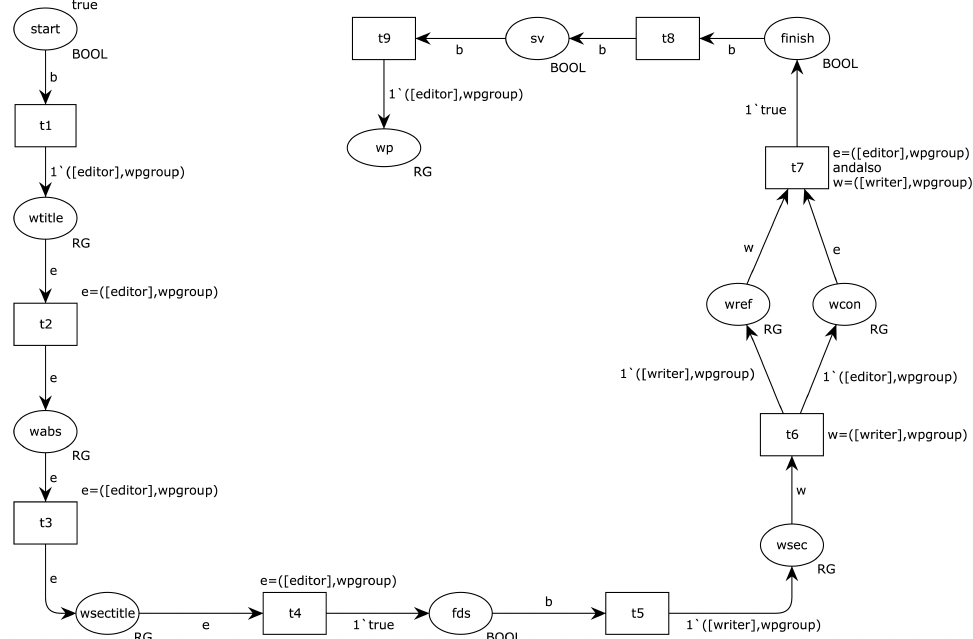
Figure 14. The CPN4M to Writing Paper : structure and inscriptions generated.